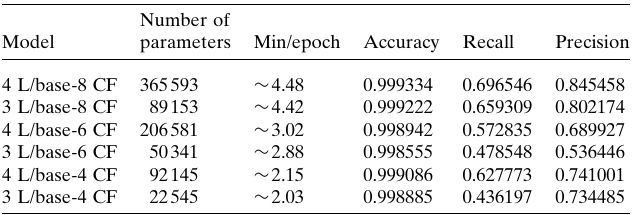
Table 2 Object segmentation performance metrics for different 3D U-net DCNN models (L: layers; CF: characteristic features) configuration and implementation after 240 epochs; absolute time per epoch is also provided and it is specific to the software and hardware specifications used in the present